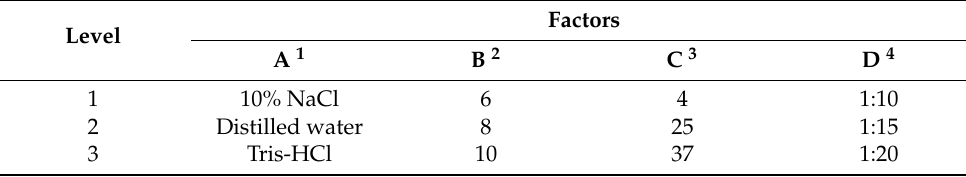
Table 1. Orthogonal test